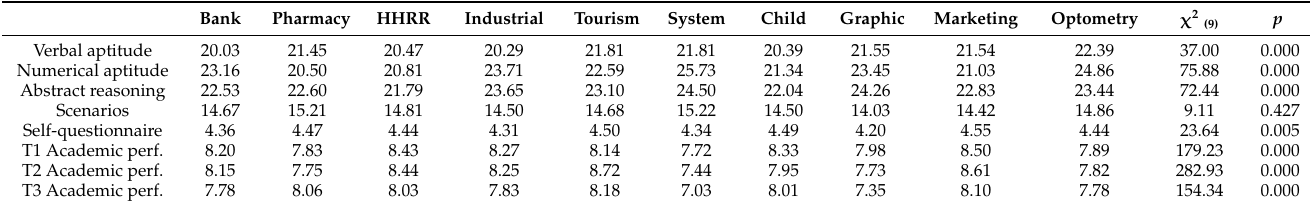
Table 3. Degree among variables under